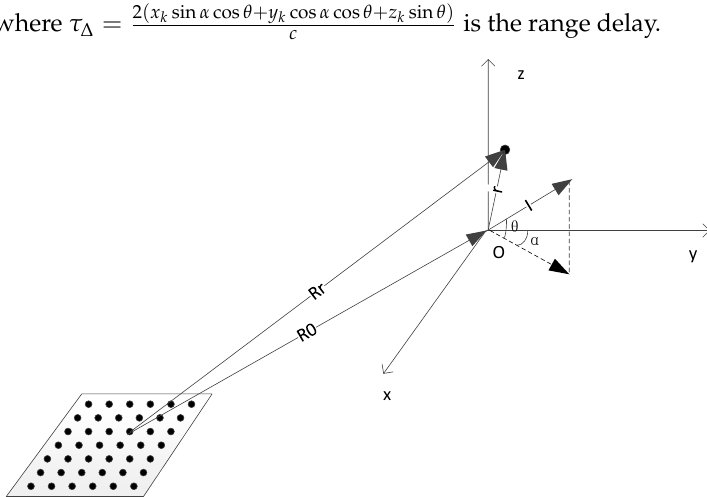
Figure 2. Schematic diagram of radar line of sight direction and coordinate system.